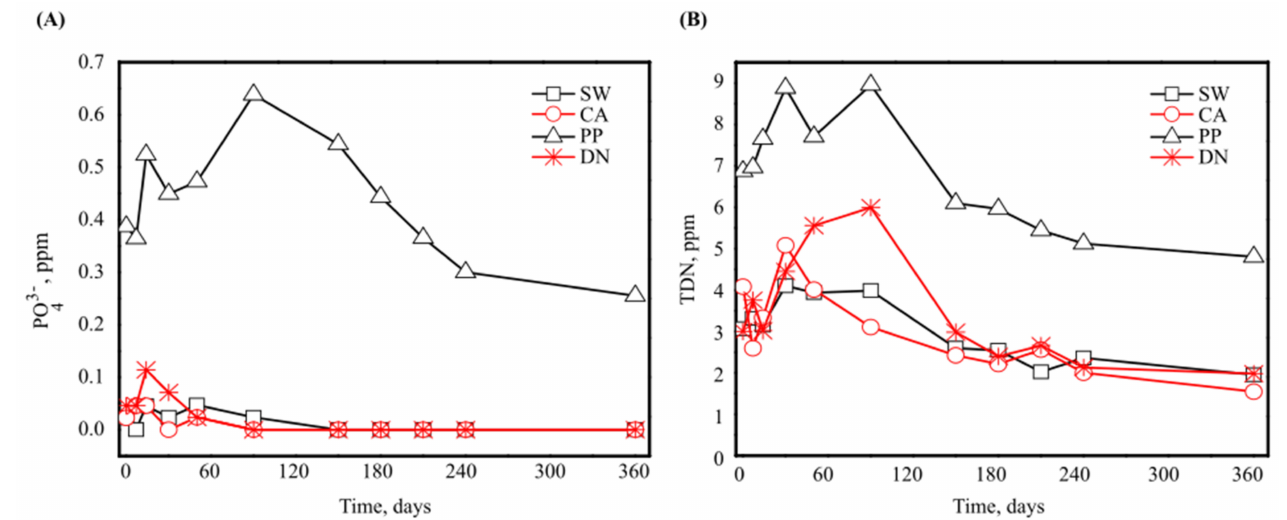
Figure 2. Phosphate (PO 43 − ) ( A ) and TDN ( B ) concentration of the incubated seawater in the presence and absence of 100 mg/L polyacrylic acid- (CA), polyphosphonate- (PP), and carboxylated dendrimeric- (DN) based